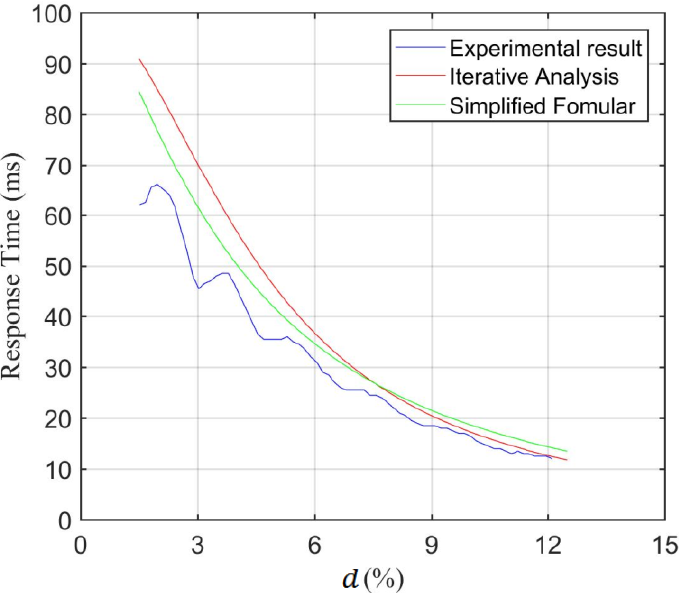
Figure 11. The transient response time under different duty cycle.